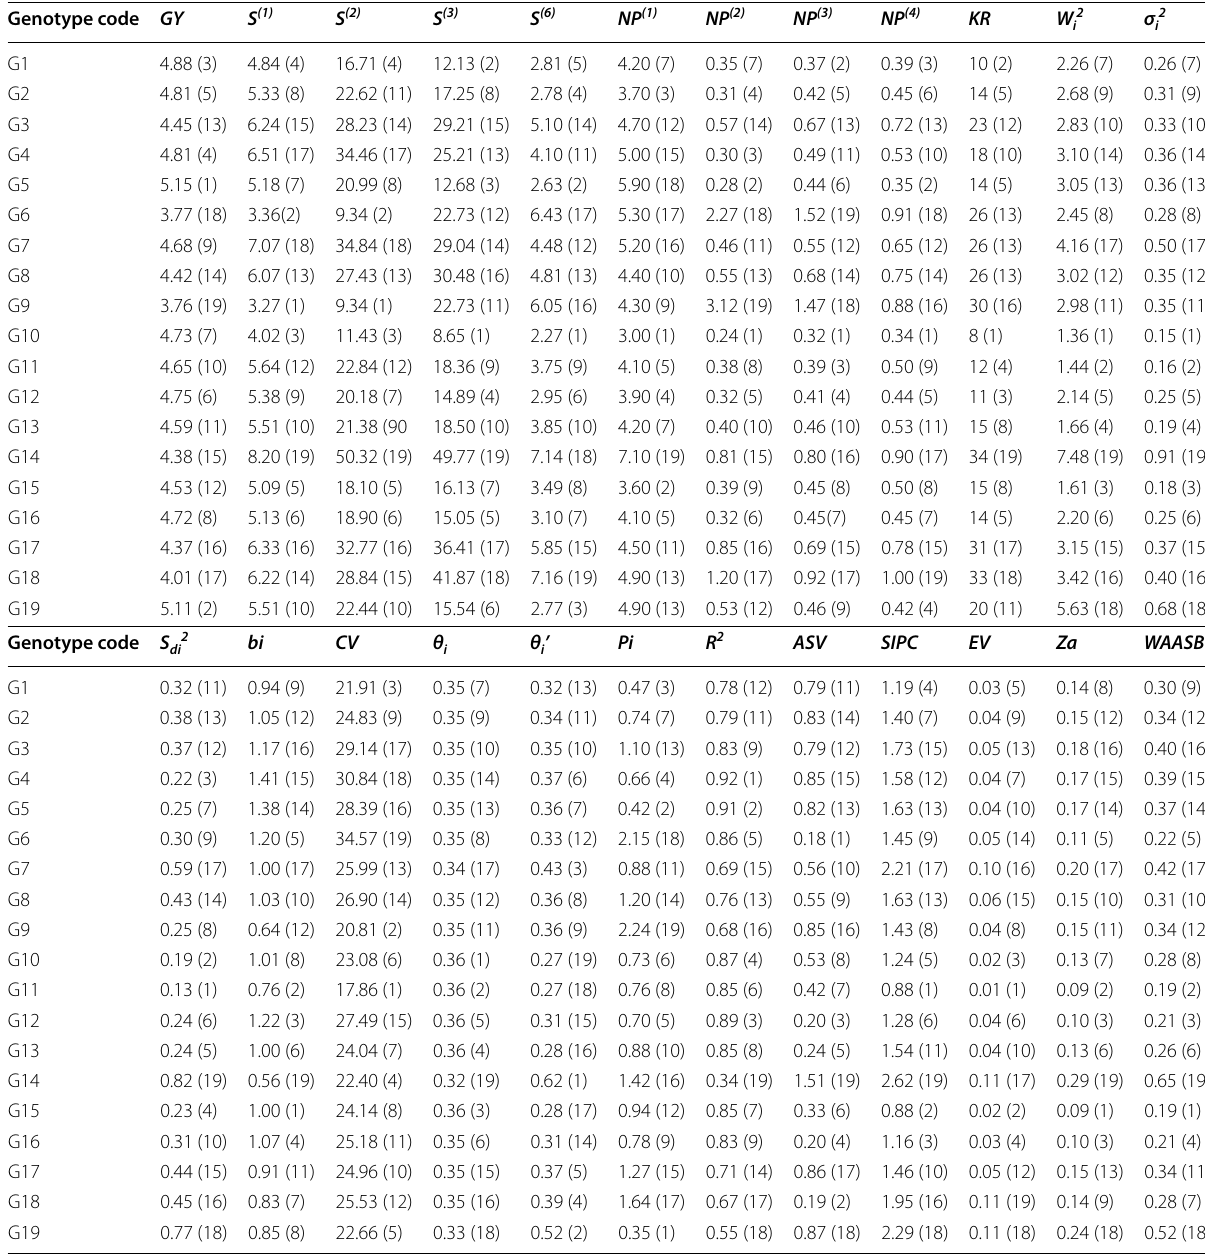
Table 3 The mean yield (GY) and stability statistics values for 19 barley genotypes across ten tested environments Genotype code